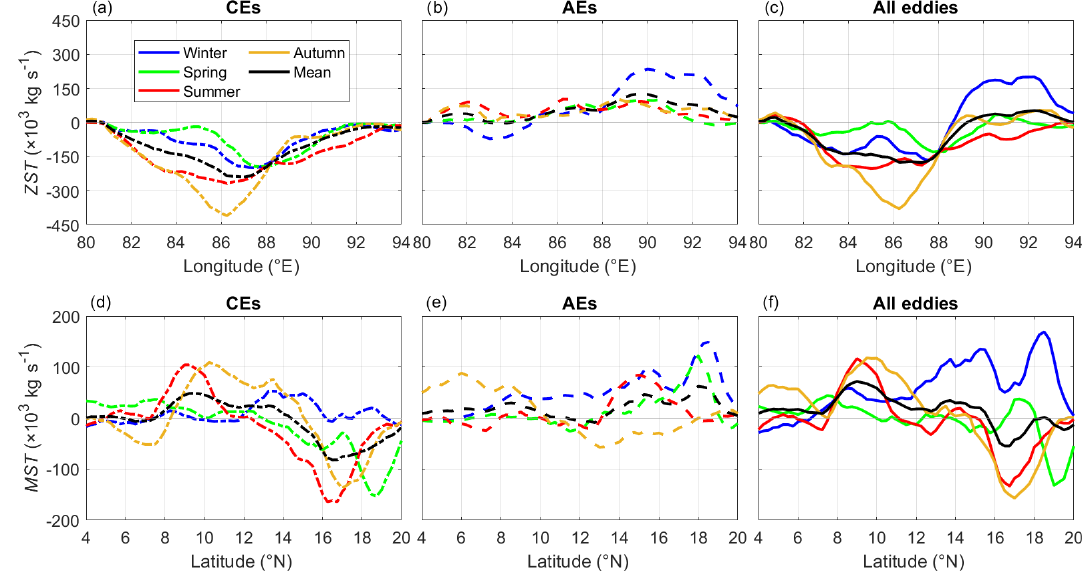
Figure 13. The meridionally integrated zonal salt transport (ZST, a–c ) at different longitudes and the zonally integrated meridional salt transport (MST, d–f ) at different latitudes by cyclonic eddies (CEs), anticyclonic eddies (AEs), and all eddies in different seasons in the Bay of